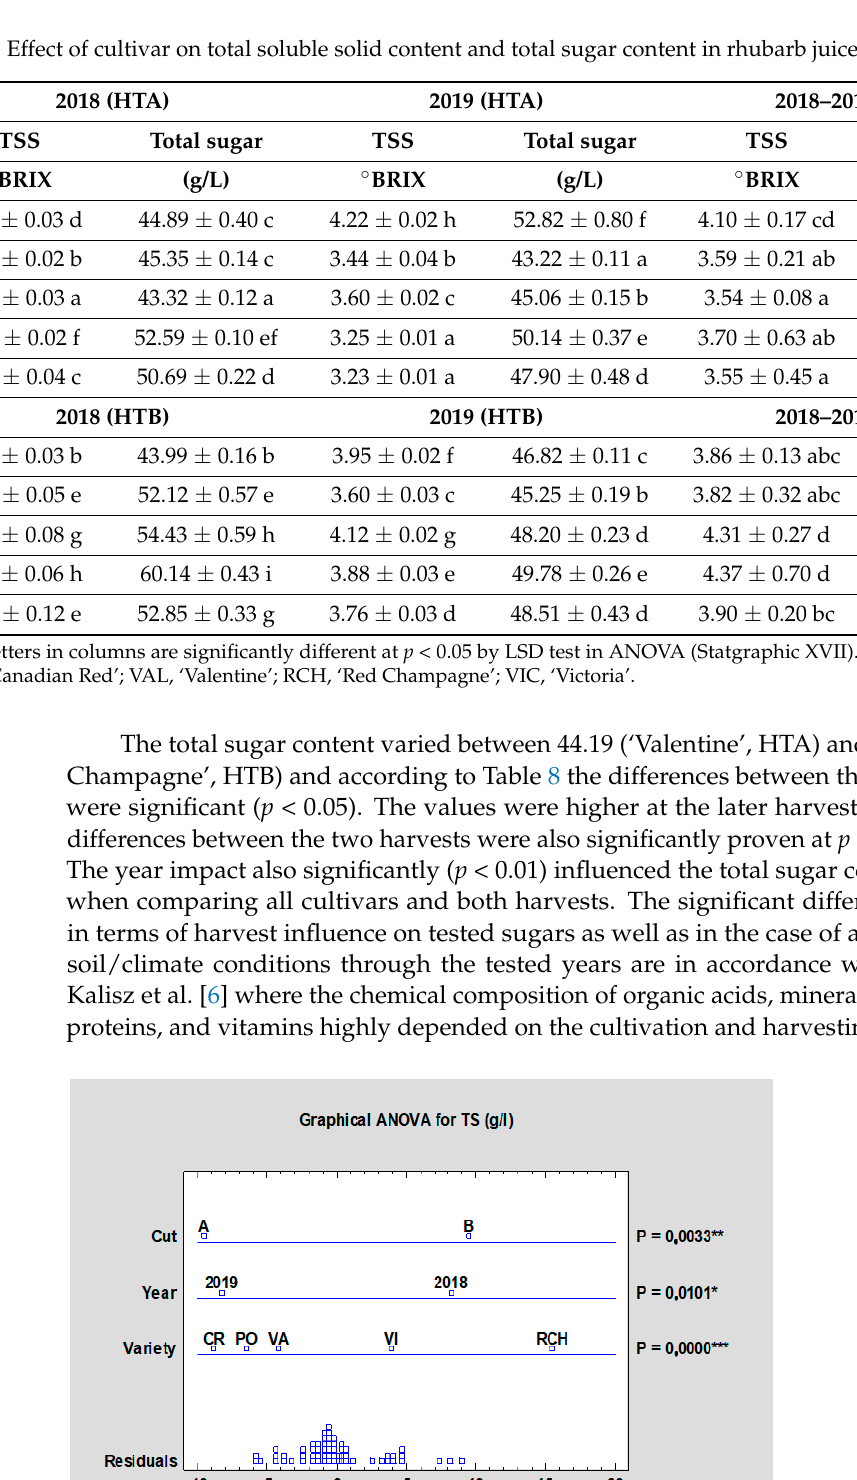
Table 8. Effect of cultivar on total soluble solid content and total sugar content in rhubarb juice.